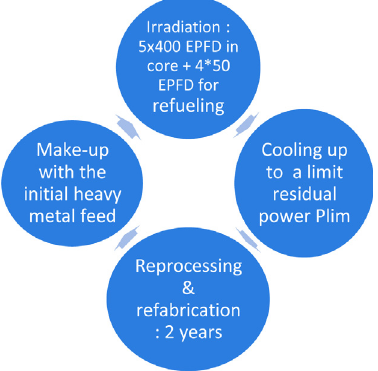
Fig. 1. Algorithm used for